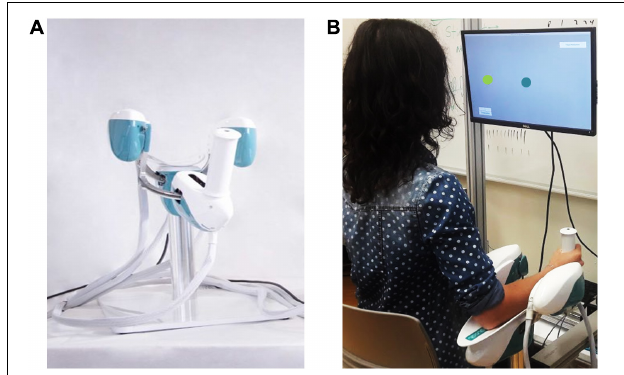
FIGURE 1 | Experimental setup depicting the Wristbot (A) and a subject performing the Joint Position Matching test (B)